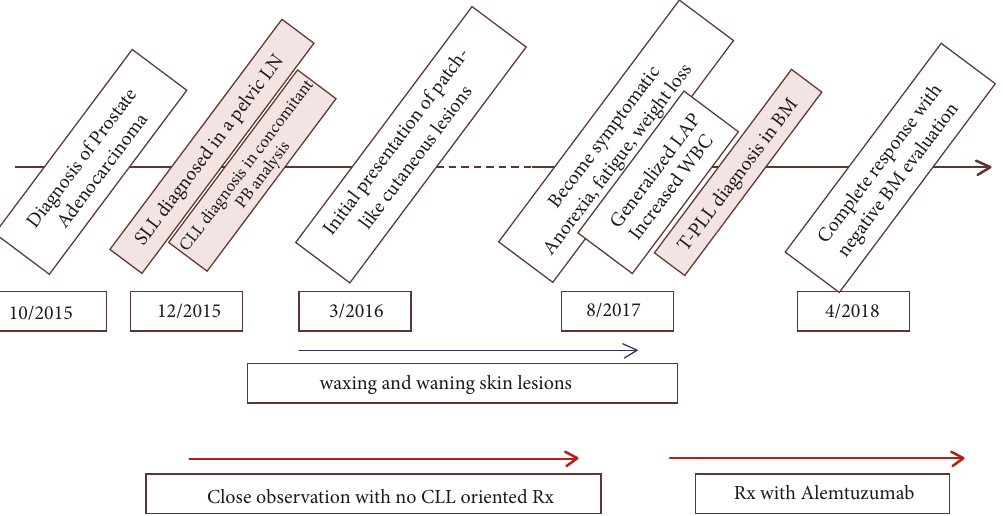
Figure 7: Timeline of most important pathologic findings from the diagnosis of prostate adenocarcinoma to T-PLL (abbreviations: BM: bone marrow, CLL: chronic lymphocytic leukemia, LAP: lymphadenopathy, LN: lymph node, PB: peripheral blood, Rx: treatment, SLL: small lymphocytic lymphoma, T-PLL: T-cell prolymphocytic leukemia, WBC: white blood cell